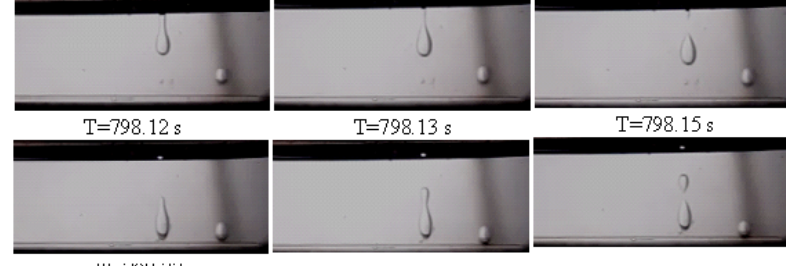
Figure 15. Pinch-o ff at top and bottom electrode (Ca E = 0 . 388). Fig. 15. Pinch-off at top and bottom electrode (Ca